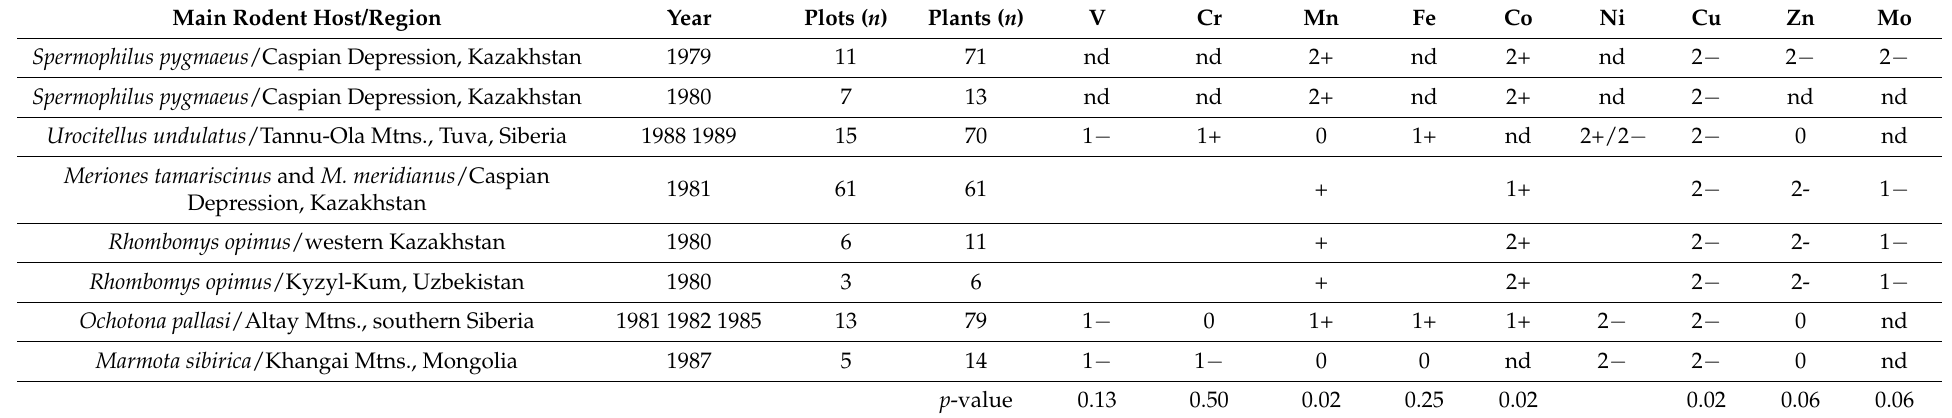
Table 2. Summary of studies of trace metals in plants associated with plague in animals. Values show relative levels of metals in plots where plague was detected compared to paired areas where plague was not detected (controls). p -values reflect exact binomial probability tests to evaluate the frequencies of plague-control plot differences, with the null assumption being that differences in concentrations of the elements within plague-control pairs of sites would be equally positive and negative and excluding pairs that had no data or showed no substantial differences